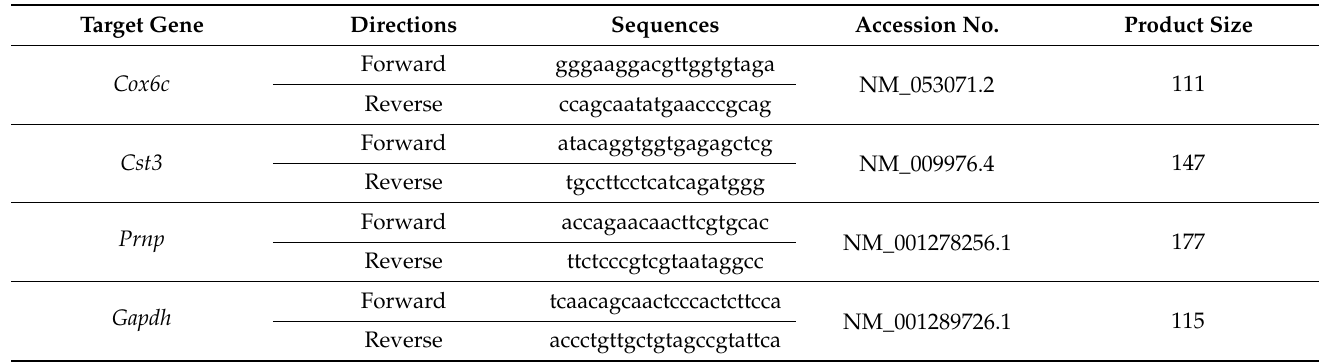
Table 1. Primers used for real-time quantitative polymerase chain reaction analysis.